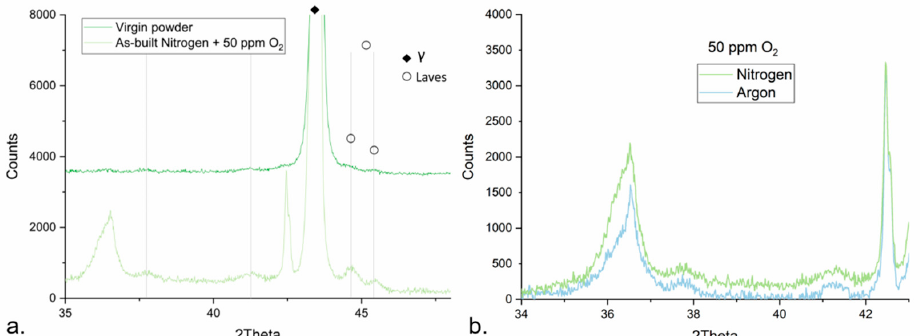
Figure 5. ( a ) XRD pattern at low angles with indexed peaks of the virgin feedstock Alloy 718 powder used to build the studied samples, together with the XRD pattern of a cube built using nitrogen with 50 ppm residual oxygen. ( b ) Close-up on the XRD pattern at low diffraction angles of the Alloy 718 cubes built under argon and nitrogen with 50 ppm residual oxygen.